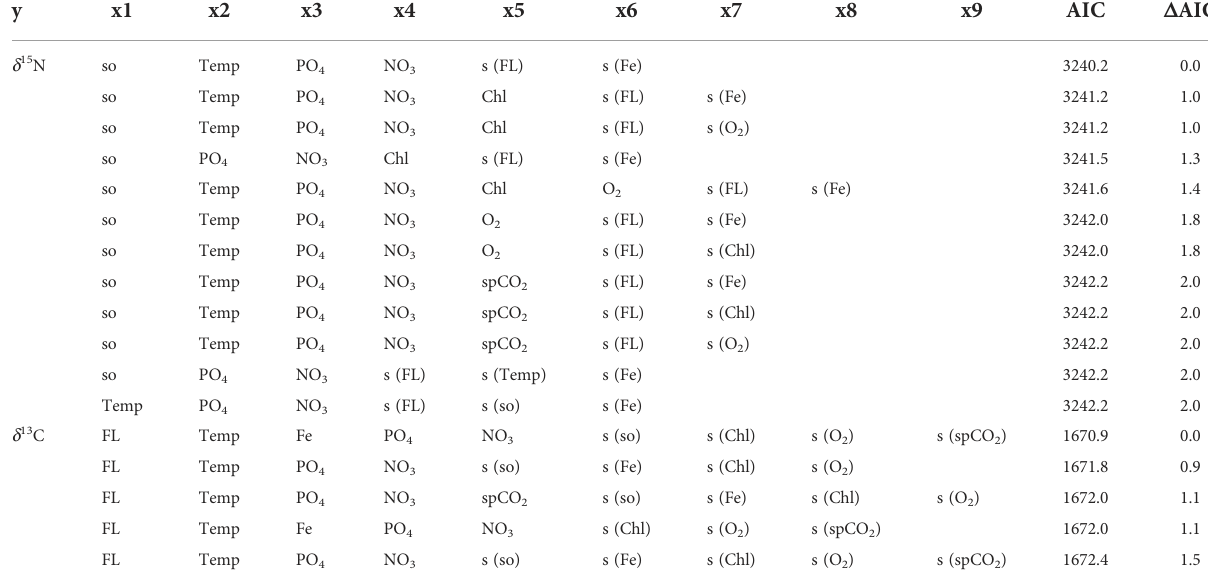
TABLE 1 Results of model selection based on the Akaike information criterion (AIC). Models with D AIC ≤ 2 are